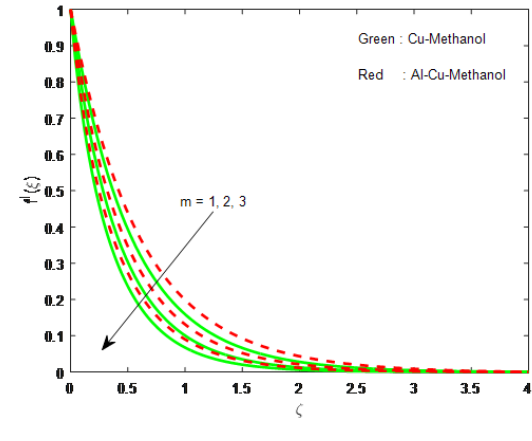
Fig. 20: Impression of m on f (cid:48) ( ξ )